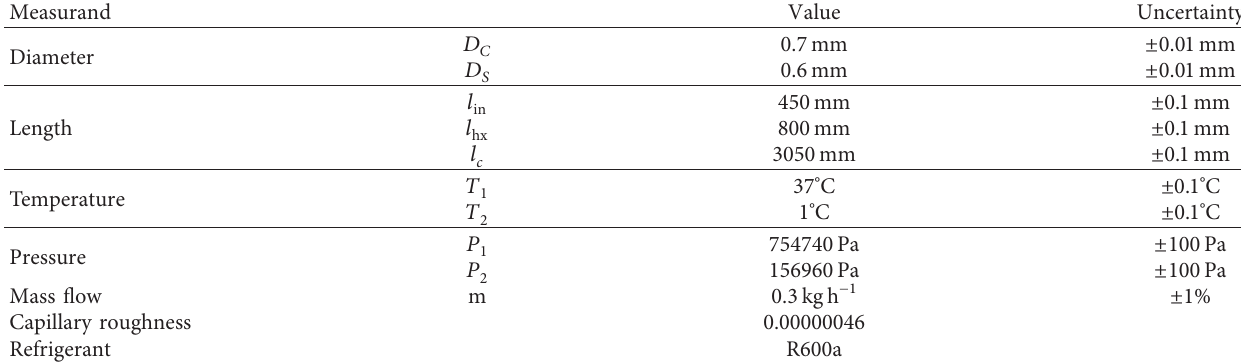
Figure 3: Refrigerator refrigeration system. Table 1: The calculation parameters of the